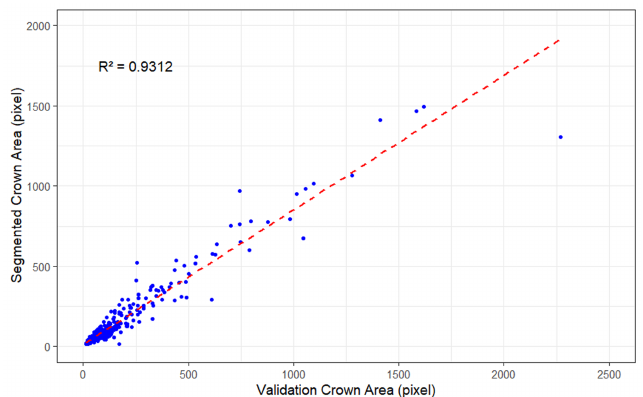
Figure 10. Relations between the evaluation crown area and the segmented crown area, both in pixels. The red dashed line represents the linear